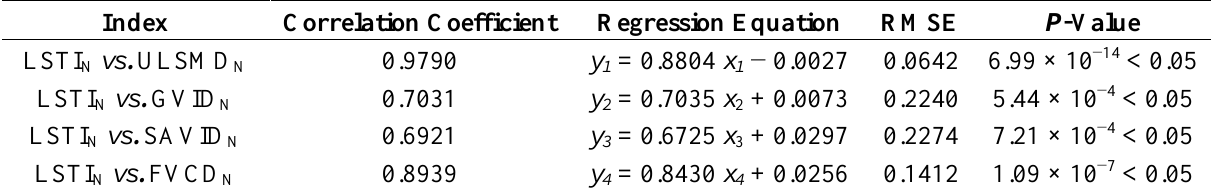
Table 8. Result of regression analysis between LSTI N and ULSMD N , GVID N , SAVID N , FVCD N